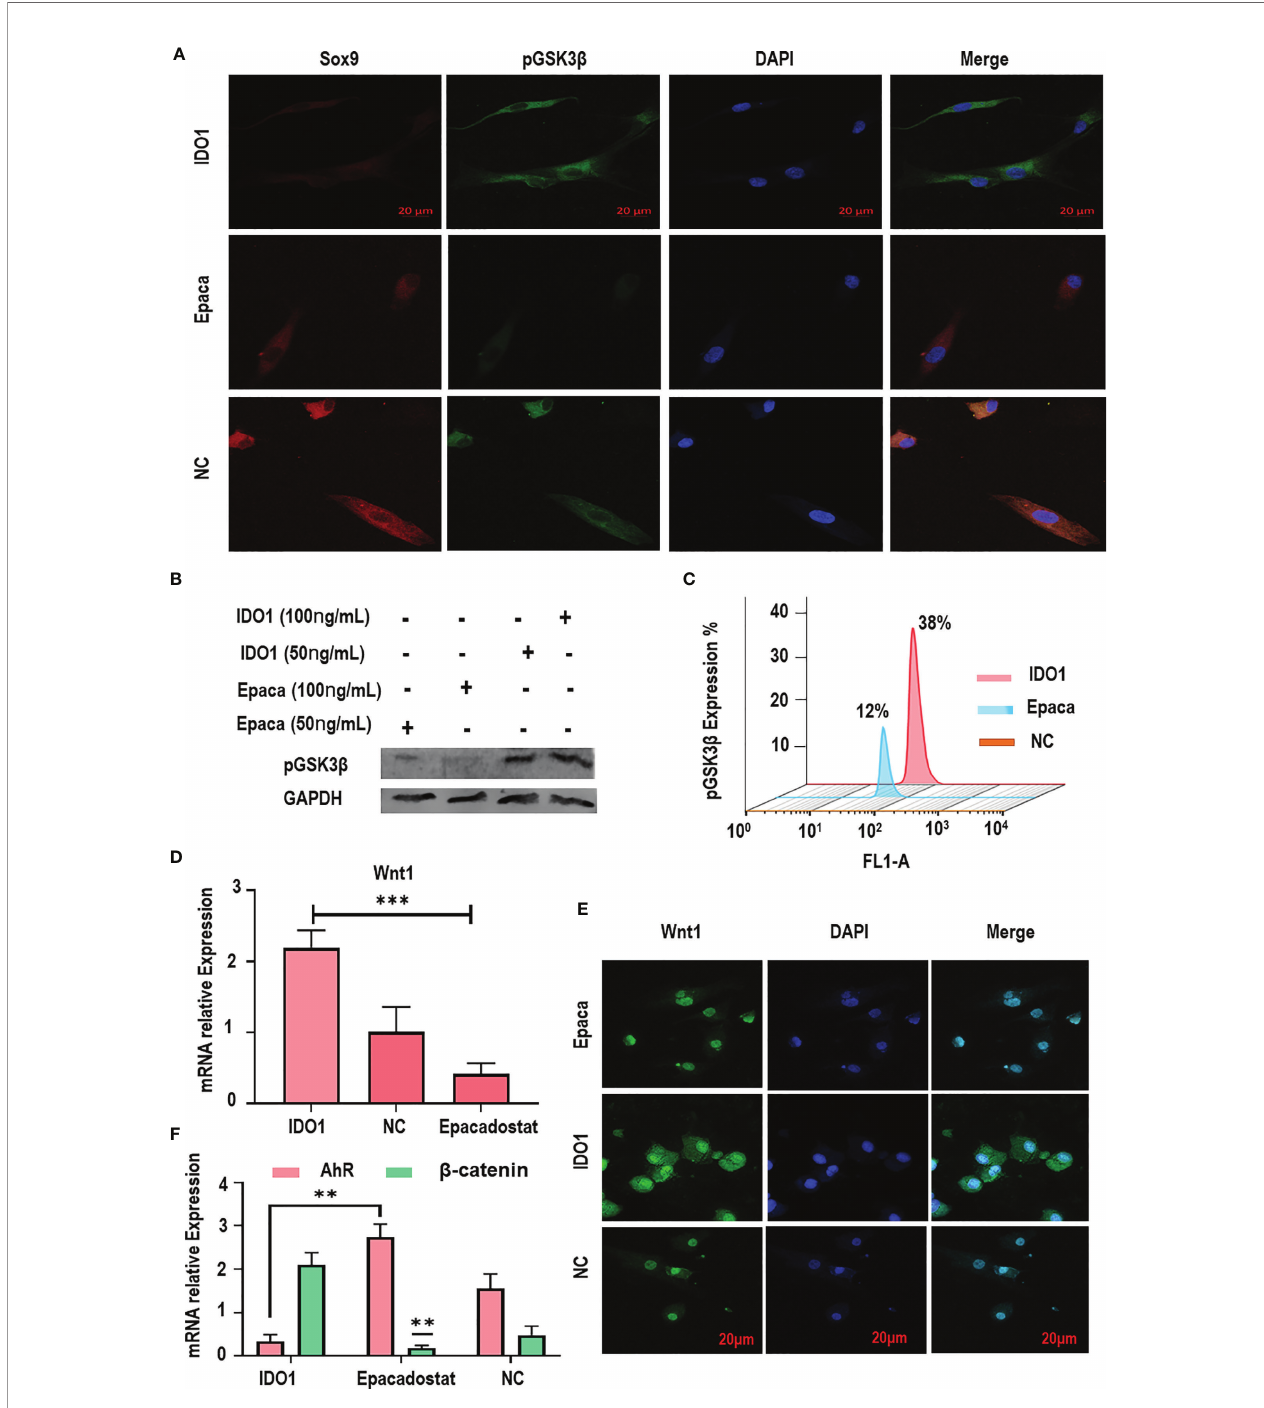
FIGURE 4 | IDO1 decreases the expression of GSK3 b in MSCs through inducing its phosphorylation. (A) The immuno fl uorescence expression of pGSK3 b showed increased expression under IDO1 effects, while it was reduced by Epacadostat, suggesting the inhibition of GSK3 b phosphorylation by Epacadostat. (B) The western blot expression of pGSK3 b under the effect of IDO1 compared to Epacadostat in the MSCs; the effect of two different concentrations showed a change in the expression of phosphorylation protein. (C) The expression of pGSK3 b under the effect of IDO1 compared to Epacadostat by fl ow cytometry. (D) The expression of Wnt1 in the MSCs under the effect of Epacadostat compared to IDO1. (E) The immuno fl uorescent expression of Wnt1 in the MSCs under the effect of Epacadostat compared to IDO1. (F) The expression of the AhR receptor and b -catenin in the MSCs under the effect of Epacadostat compared to IDO1. *** p < 0.001, and ** p <